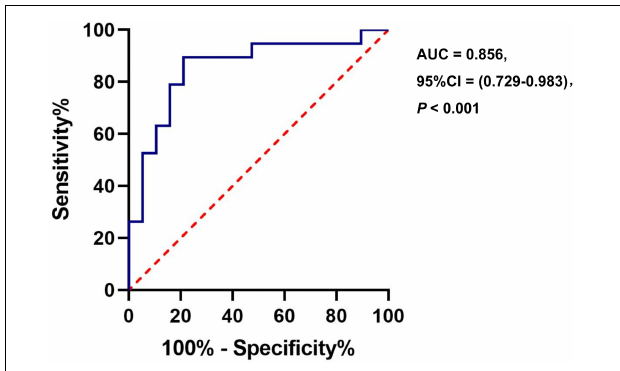
FIGURE 7 | The ROC curve of CBF in the brain regions with difference (Postcentral_R) for distinguishing the anxiety group from the non-anxiety